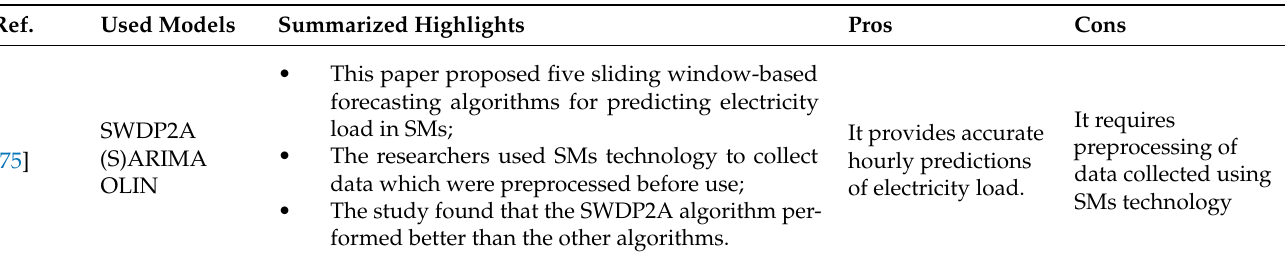
Table 2. Traditional load forecasting